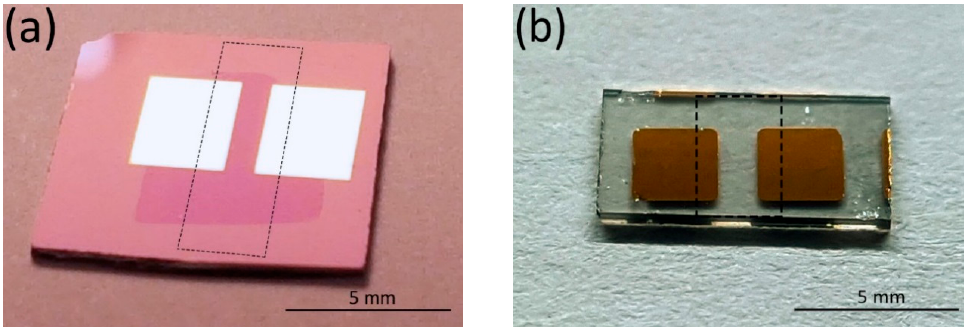
Figure 1. Photographs of gas sensor devices based on ( a ) PLD-functionalised CVD graphene on a Si/SiO 2 substrate, and ( b ) epitaxial graphene on a SiC substrate. Gaps between the electrodes are 1 × 4 mm 2 and 1 × 2 mm 2 for CVD and epitaxial graphene, respectively. The CVD graphene sheet on top of electrodes appears as a darker pink area in (a) due to slightly different reflection properties. The areas of laser deposition of V 2 O 5 are marked with dashed lines.